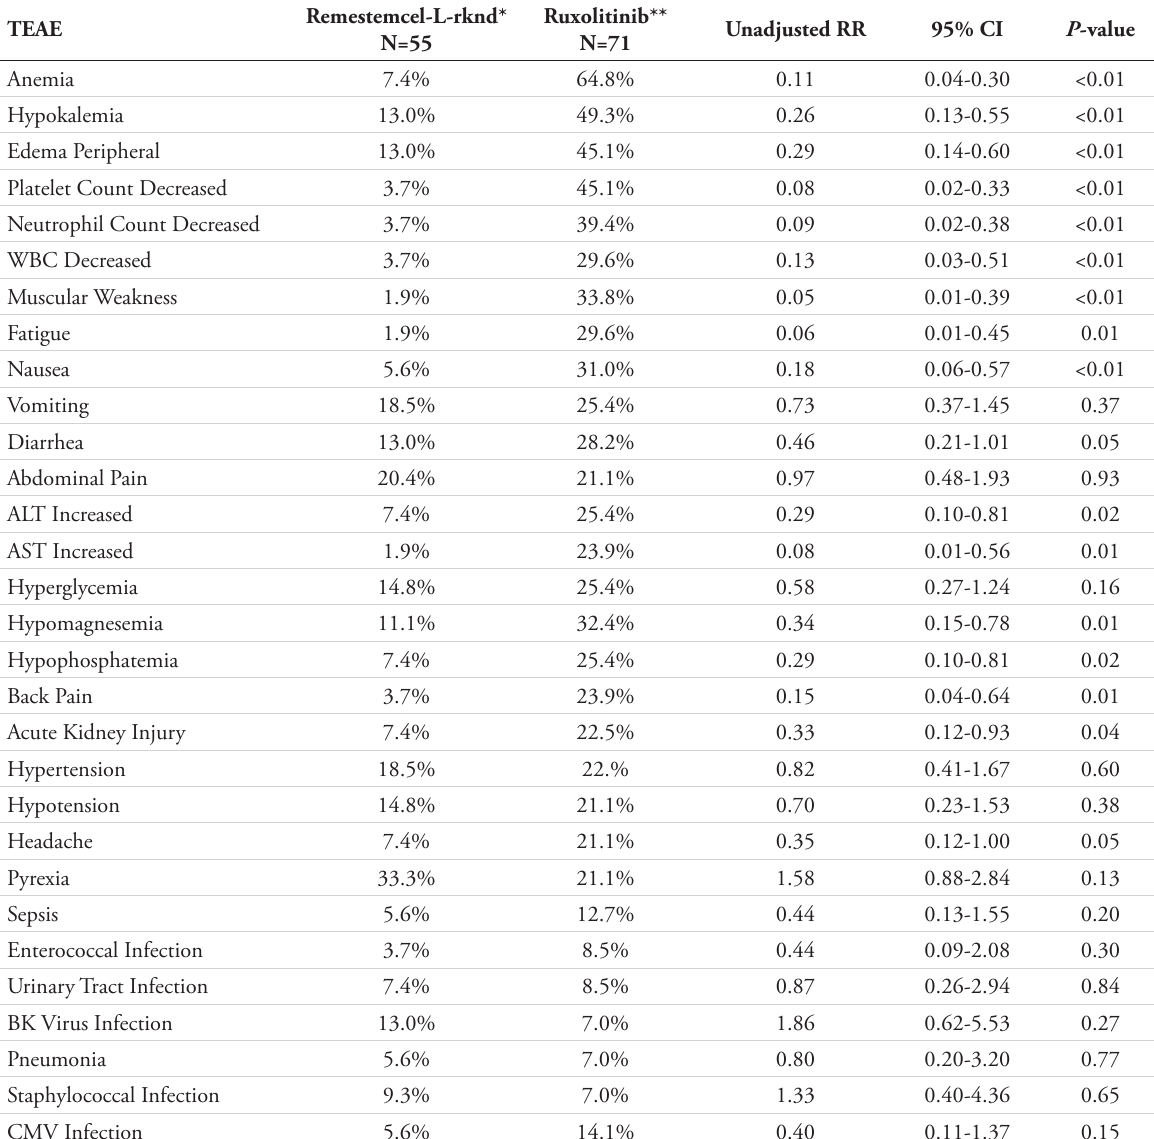
Table 3. All-grade TEAEs of Remestemcel-L-rknd Versus